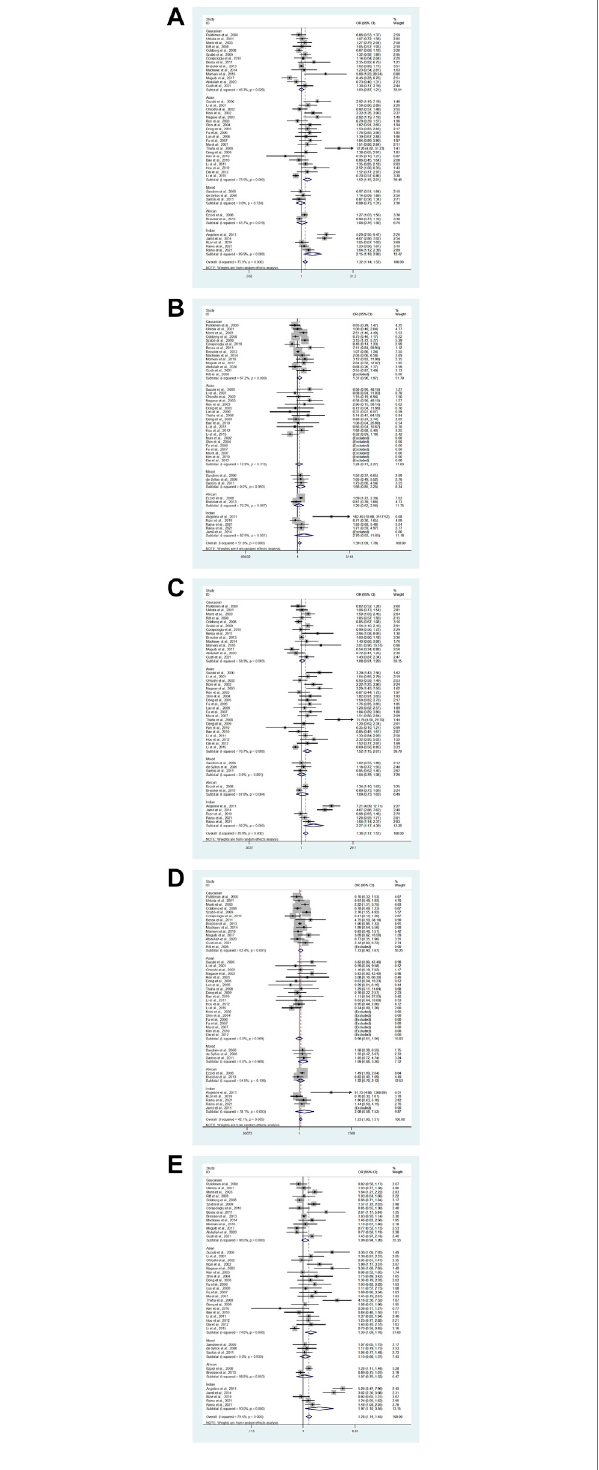
FIGURE 3 | The forest plots of all selected studies on the association between eNOS G894T polymorphism and the risk of T2DM in different races [ (A) :hybridmodel; (B) homozygousmodel; (C) dominantmodel; (D) recessive model; (E) allele